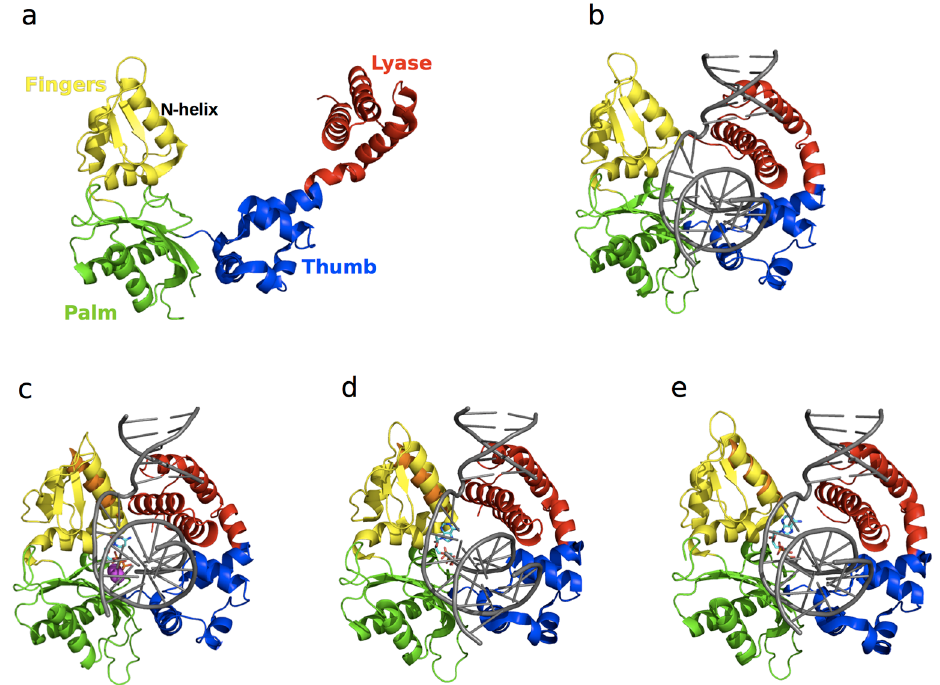
Figure 5. Structure of free and ligand ‐ bound states of Pol β . The lyase domain is shown in red while the thumb, palm, and fingers subdomains of the polymerase domain are shown in blue, green and yellow, respectively. Pol β in the ( a ) apo (PDB 1BPD) form is characterized by an open conformation; ( b ) binary complex (PDB 1BPX) formation is accompanied by a 40 Å conformational shift of the lyase domain to form a compact “open” conformation; ( c ) matched dNTP ‐ bound ternary (PDB 1BPY) complex shows a 10 Å shift of the N ‐ helix of the fingers domain relative to the binary form (in orange), leading to the formation of a “closed” conformation. Binding of mismatched dNTPs has been shown to adopt ( d ) closed (PDB 3C2M) and ( e ) open (PDB 4F5P) conformations of the N ‐ helix. For comparison, the N ‐ helix from the binary form is shown in orange in the ternary complexes in c – e , illustrating subtle yet functionally significant conformational exchange in this enzyme. DNA substrates in all the binary and ternary forms are shown in grey ( b – e ), the dNTPs in c – e are shown as cyan sticks, and the Mg 2+ ions are represented as magenta spheres in c.